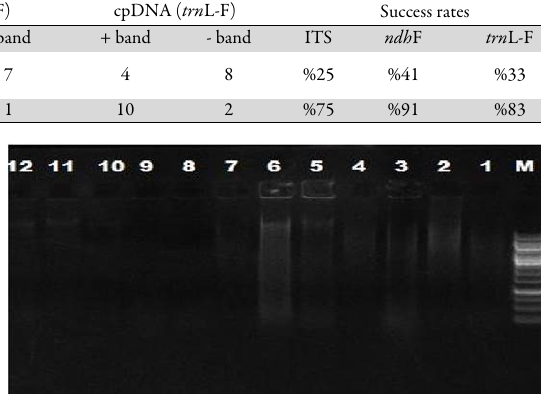
Fig. 1. Gel image of Inula gDNA’s obtained by Phenol Chloroform Isoamyl Alcohol Protocol 1. I. anatolica , 2. I. fragilis , 3. I. sechmenii , 4. I. mariae , 5. I. heterolepsis , 6 . I. macrocephala , 7. I. britannica , 8. I. salicina , 9. I. inuloides , 10 . I. helenium subsp. orgyalis , 11. I. aucheriana , 12. I. discoidea